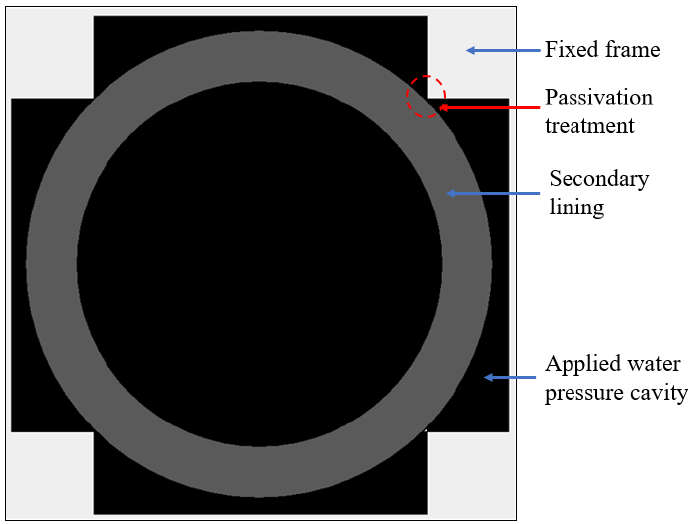
Figure 17. Method 2 numerical model diagram.